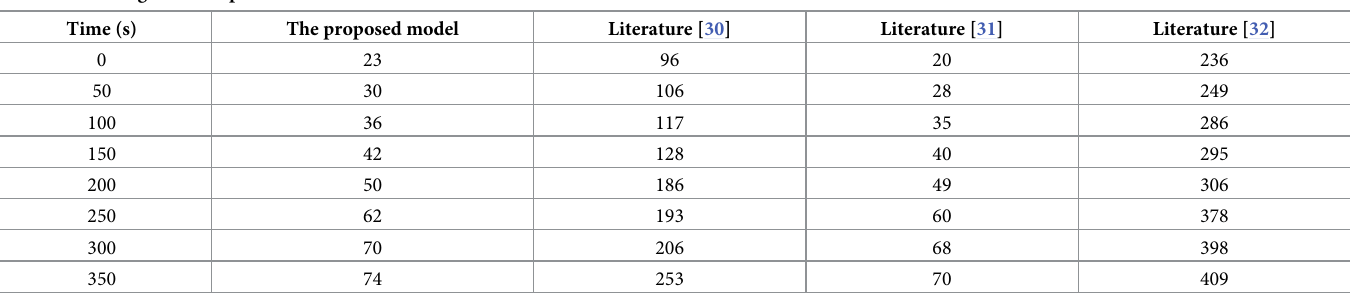
Table 2. Running time comparison of different models.